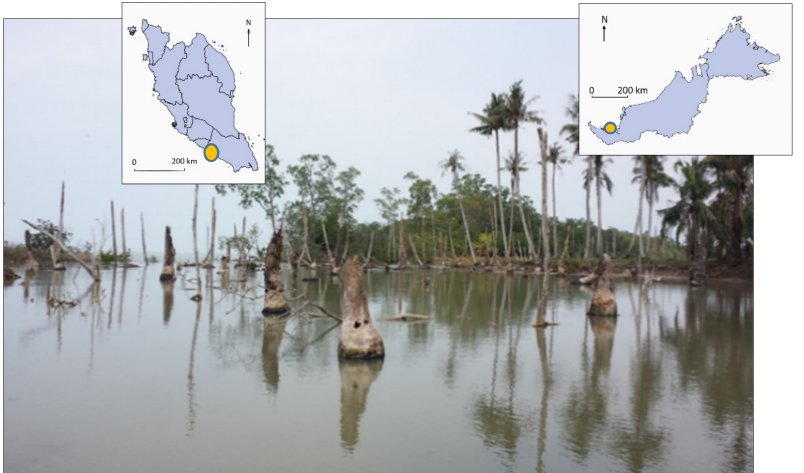
Figure 23. Abandoned inundated coconut plantation as “Do Nothing” in Batu Pahat [143]. Reprinted from Impact of Sea Level Rise on Low Lying Area of Coastal Zone: The Case of Batu Pahat, 2016; public full text by Research